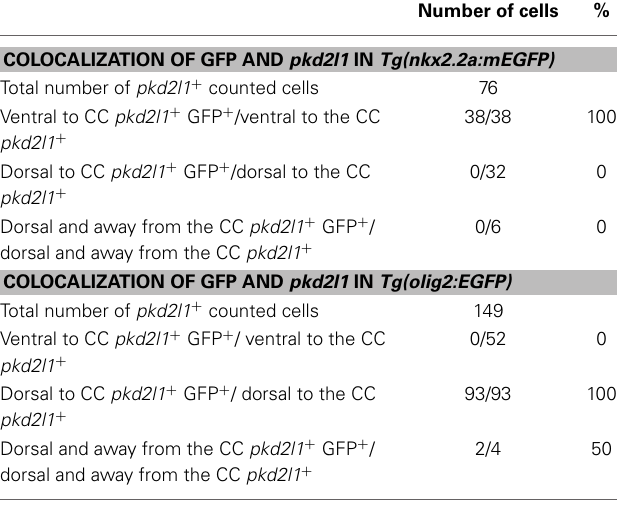
Table 2 | Distribution of ventral and dorsal pkd2l1 + cells expressing GFP in Tg(nkx2.2a:mEGFP) and Tg(olig2:EGFP) zebrafish transgenic lines at the 30-somite stage.